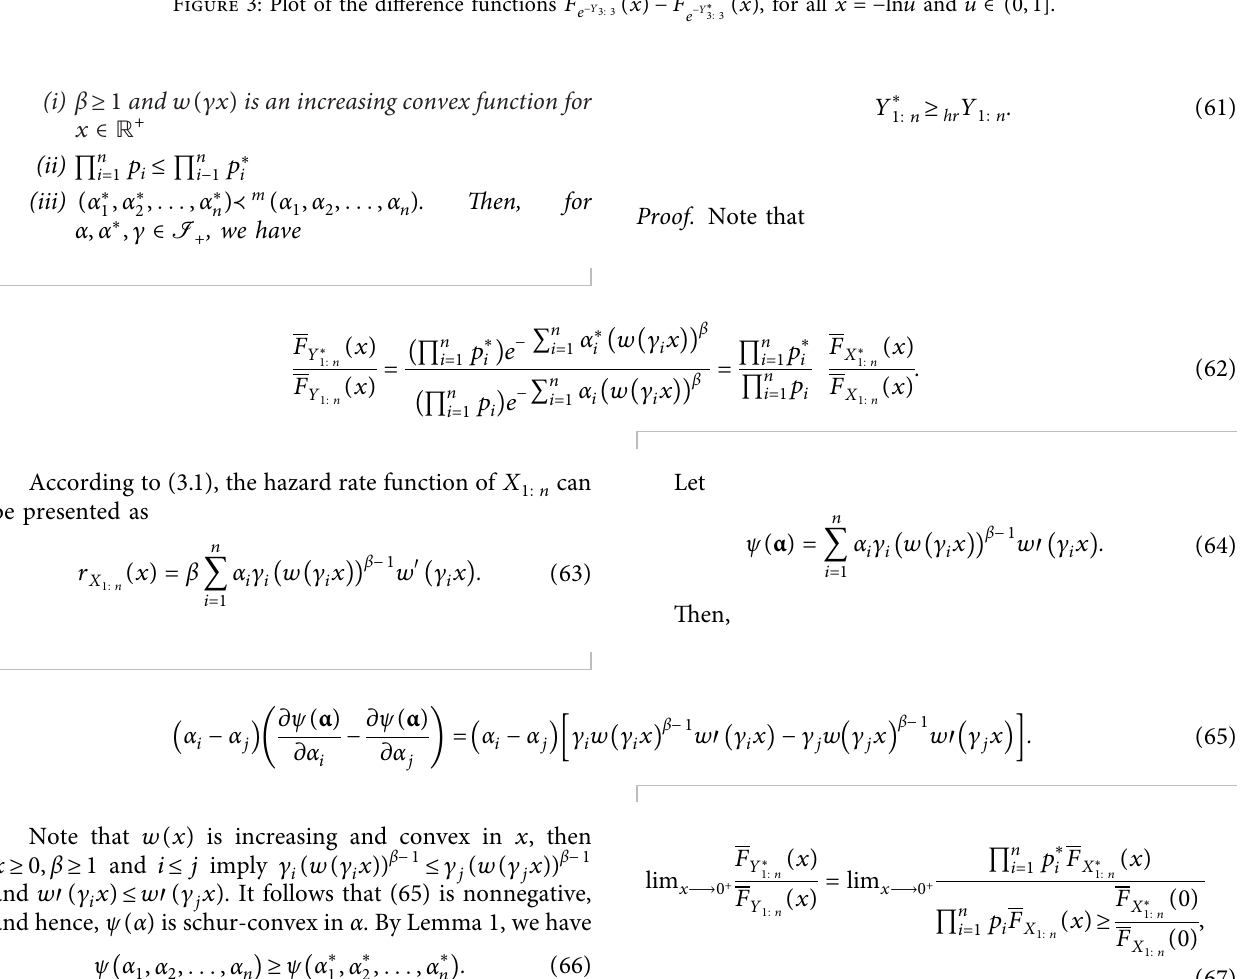
Figure 3: Plot of the difference functions F